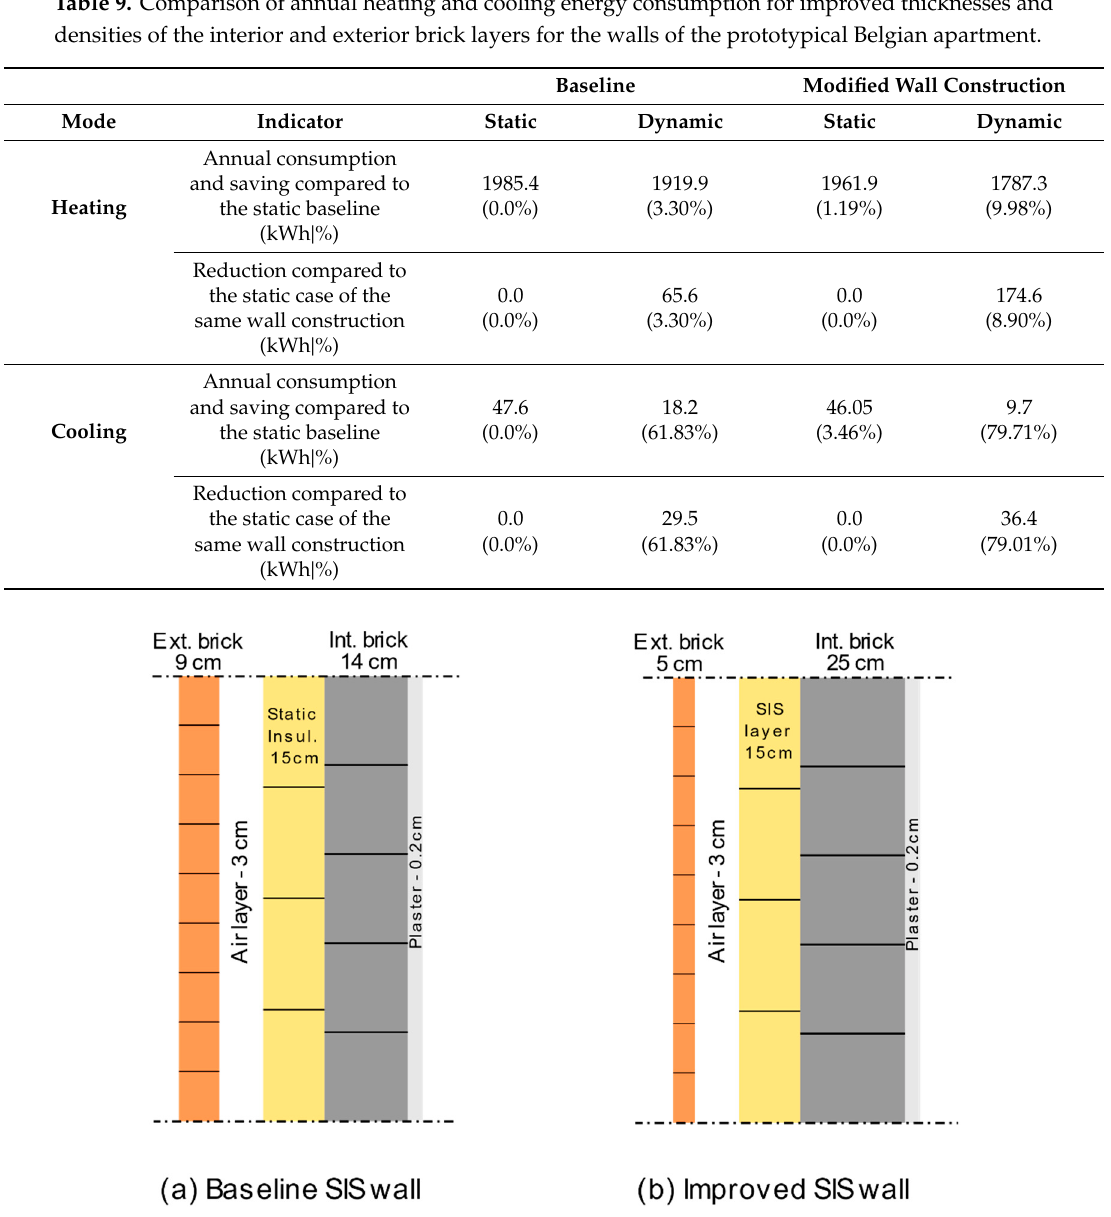
Figure 4. Cross sections of ( a ) Baseline SIS wall composition and ( b ) Improved SIS wall composition. Table 9. Comparison of annual heating and cooling energy consumption for improved thicknesses and densities of the interior and exterior brick layers for the walls of the prototypical Belgian apartment.